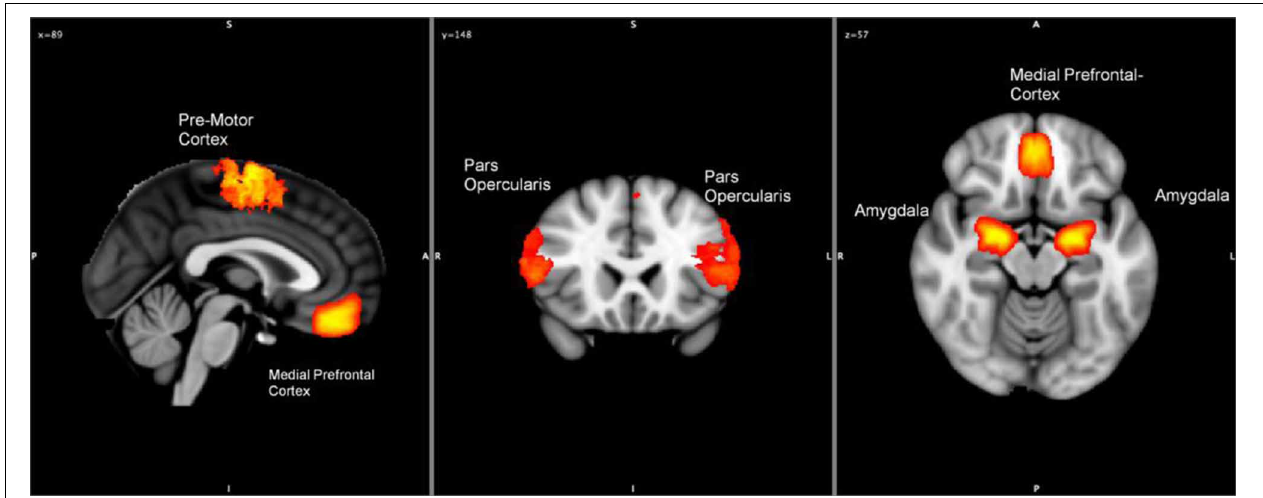
FIGURE 1 | Hypothetical locations of the regions active during the processing of emotional-valenced stimuli (amygdala, pars opercularis, motor cortex, and medial prefrontal